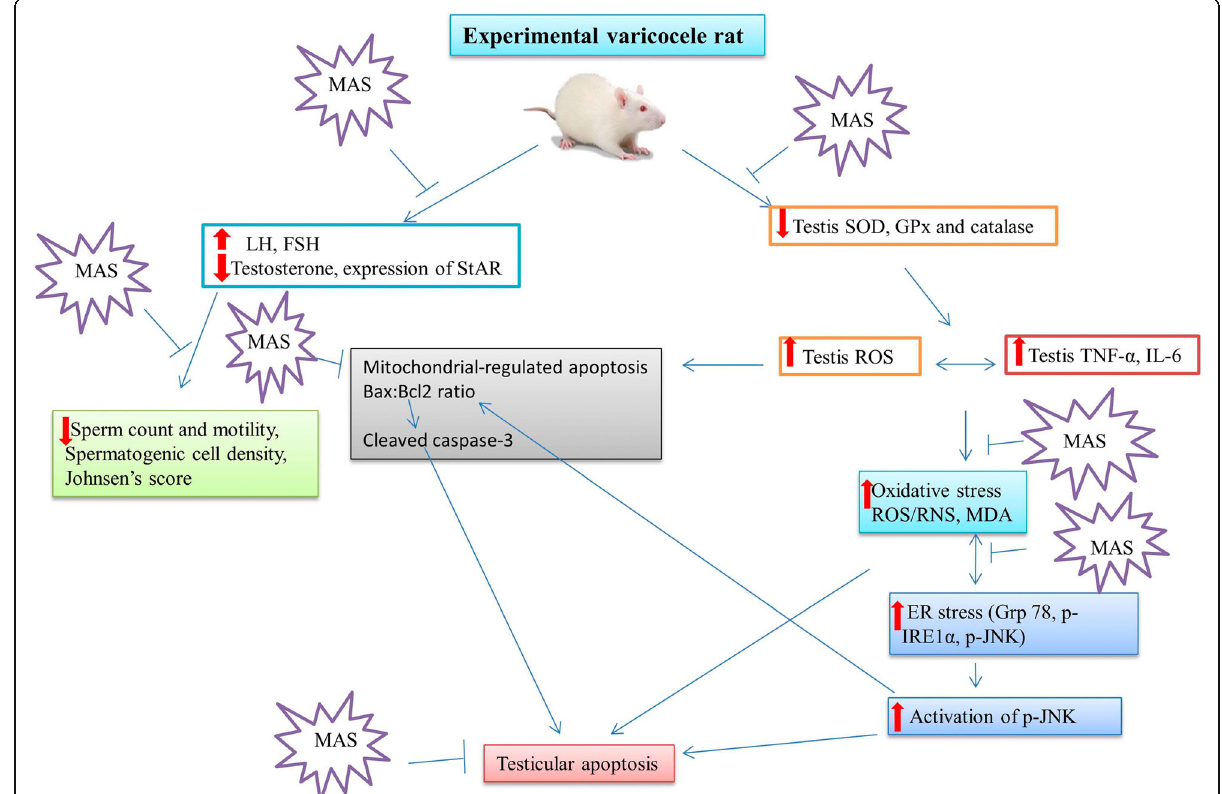
Fig. 4 Schematic diagram showing molecular mechanism of varicocele-induced testicular dysfunction and its prevention by MAS. ER: Endoplasmic reticulum; ROS/RNS: Reactive oxygen species/reactive nitrogen species; MDA: Malondialdehyde; SOD: Superoxide dismutase; GPx: Glutathione peroxidase; IL-6: Interleukin-6; TNF- α : Tumor necrosis factor- α ; GRP-78: Glucose-regulated protein-78; p-JNK: Phosphorylated c-Jun-N- terminal kinase; p-IRE1 α : Phosphorylated Inositol-Requiring Transmembrane Kinase/Endoribonuclease 1 α ; JNK: C-jun-N-terminal kinase; Bax: BCL 2 associated X protein; Bcl-2: B-cell lymphoma 2 ; StAR: Steroidogenic acute regulatory